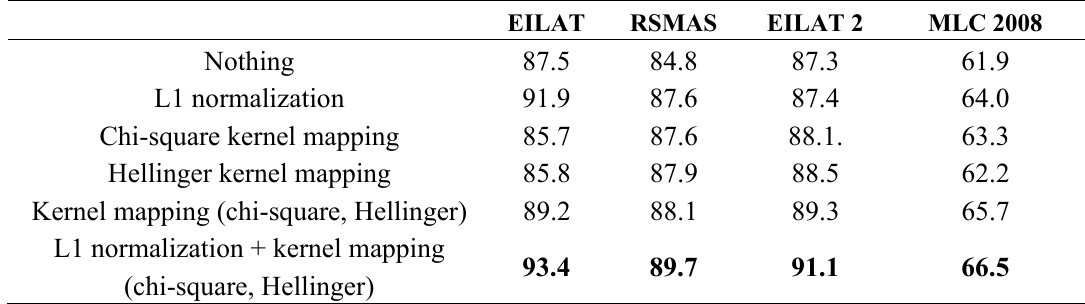
Table 6. Overall accuracy (%) with different normalization and kernel mapping methods as evaluated with the EILAT, RSMAS, EILAT 2 and MLC 2008 datasets. In this experiment, fixed configurations on the rest of the steps are as follows. Image enhancement: contrast limited adaptive histogram specification (CLAHS); feature extraction: completed local binary pattern (CLBP), GLCM, Gabor filter response, opponent angle, hue channel histogram; dimension reduction: principal component analysis (PCA); prior: class frequency; classifier: k-nearest neighbor